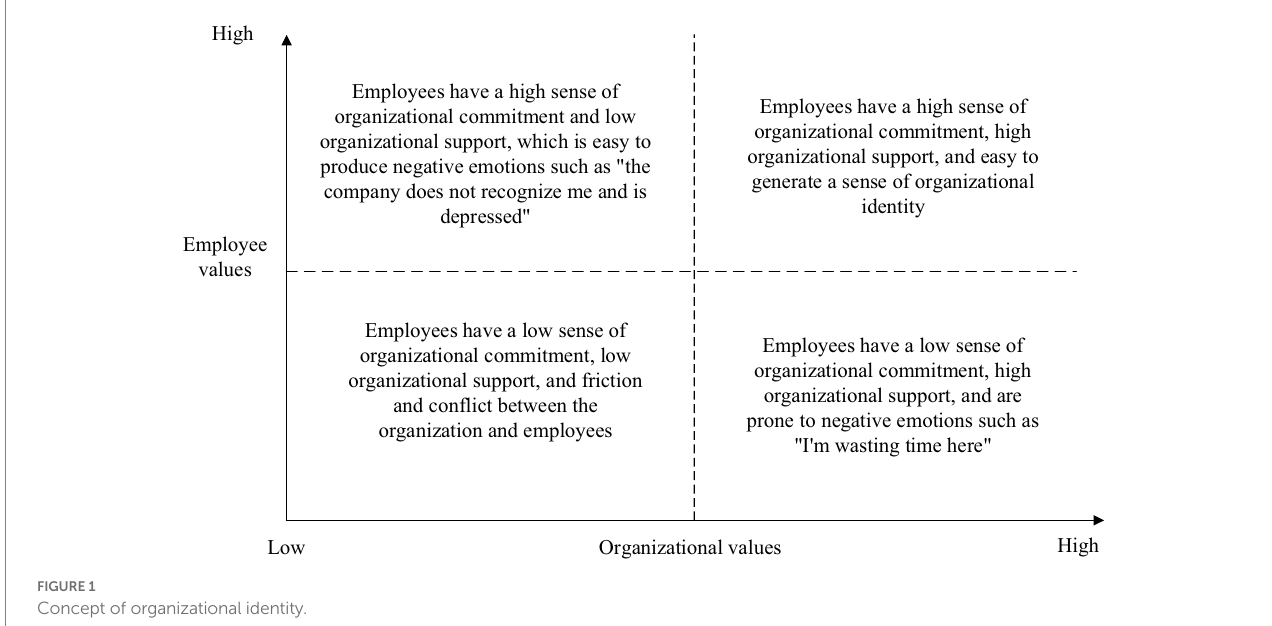
FIGURE 1 Concept of organizational